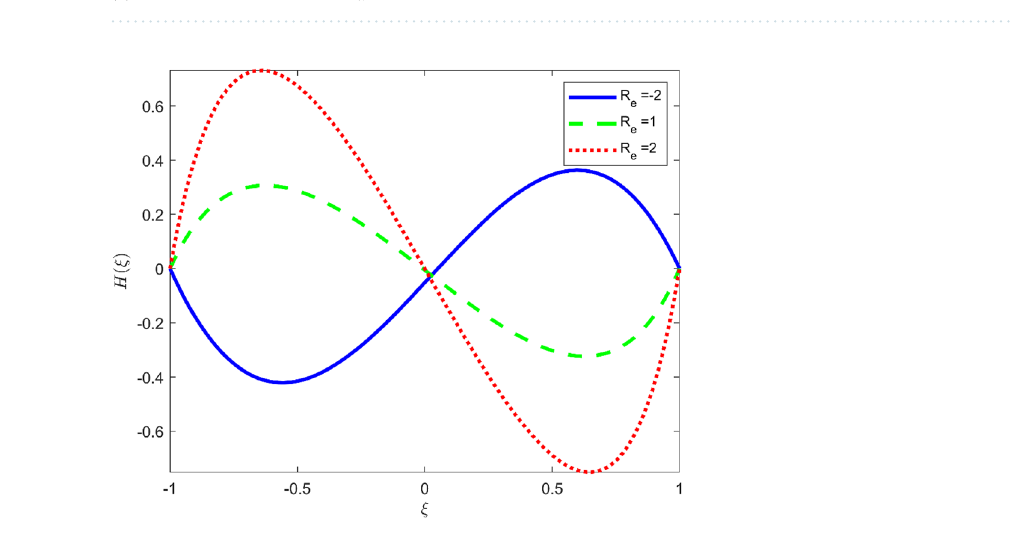
Figure 18. Effect of R e upon velocity profile H (ξ) , for selected values of β = 0.2, m = 1, Ha = 1, φ 1 = φ 2 =